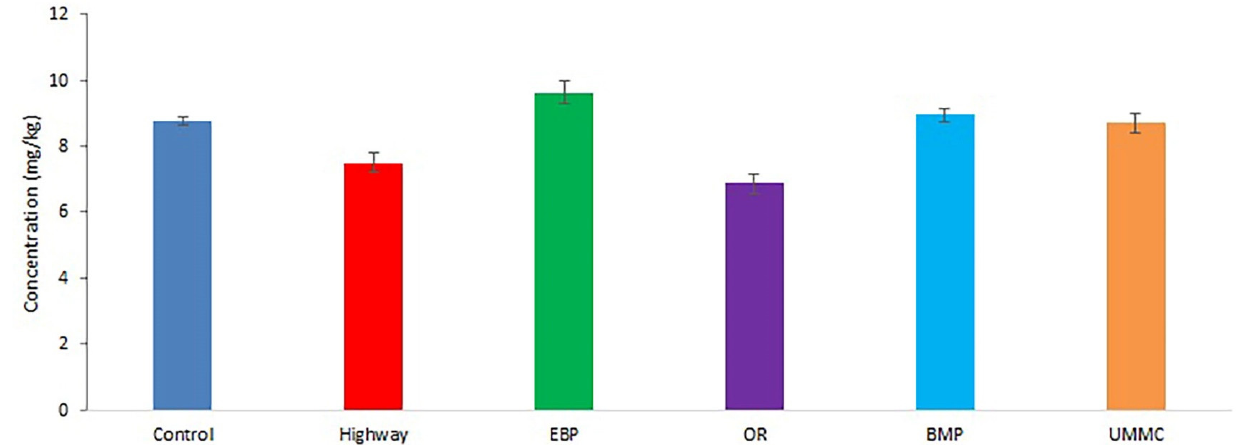
Figure 1. Cu concentration (mean ± 95% confidence interval) in coltsfoot from studied areas. The Fe content in coltsfoot ranged from 941 to 4321 mg kg − 1 (Figure 2). Similar Fe concentrations in herbs were found in Egypt [36] and Malaysia [37]. Fe content in plants from OR, EBP, and BMP was elevated by 40–55%. The highest Fe concentration was at the UMMC, exceeding the control level by 4.5 times. Presumably, chimneys of steelmaking